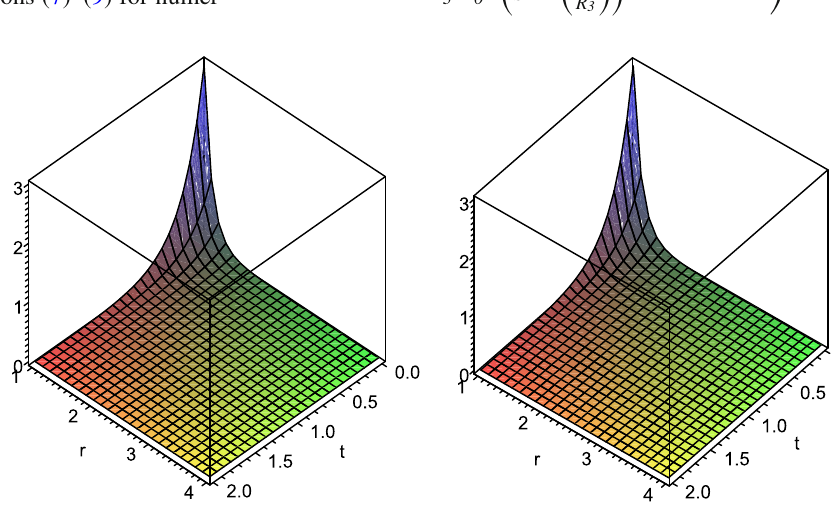
Fig. 2 The behavior of ρ + p r and ρ + p t with respect to r and t . The model parameters are taken as α = − 0 . 5, h = 1, R 2 = 1 and r 0 = 1 in 5-dimensions in the left and right plots,